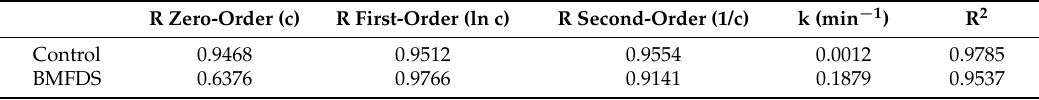
Table 3. Degradation kinetics parameters β -carotene in the presence of BMFDS under UVA irradiation. R Zero-Order (c) R First-Order (ln c)